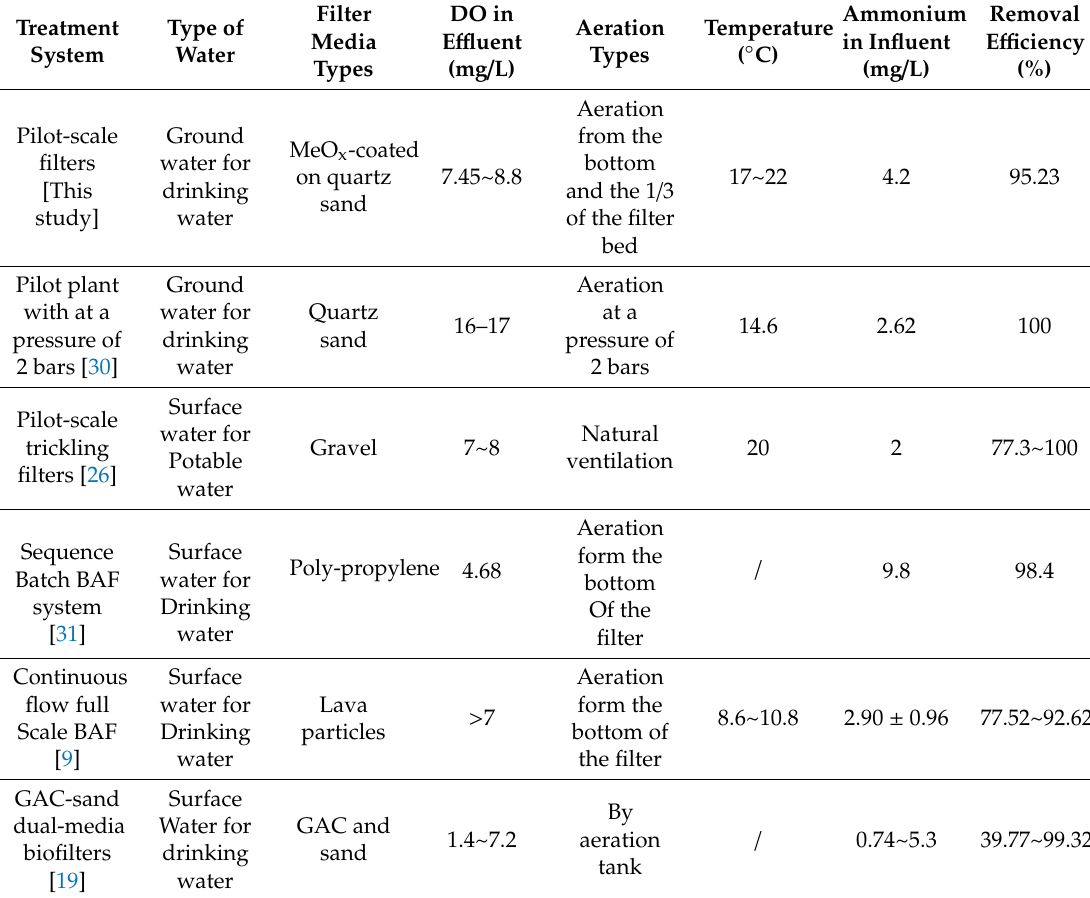
Table 3. Comparison of ammonium removal e ffi ciency between previous and current